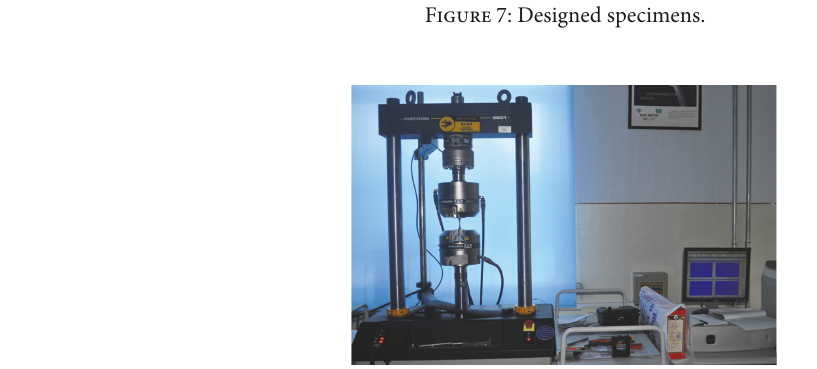
Figure 8: Test setup.